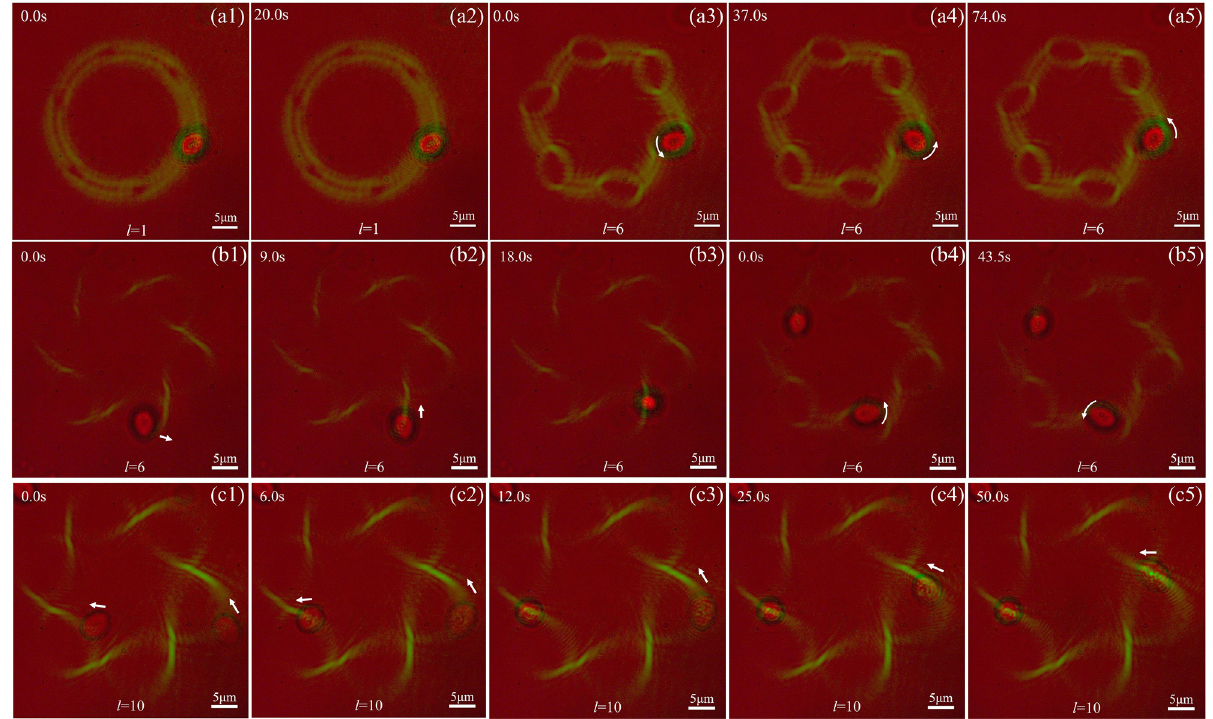
Figure 7: Manipulation of yeast cells by HO-OVL. (a1) – (a5) Irradiation of the yeast cell by HO-OVL with l = 1, which was subsequently switched to l = 6. (b1) – (b5) Irradiation of the yeast cell by HO-OVL with l = 10, which was switched into l = 6. (c1) – (c5) Simultaneous rotations of two yeast